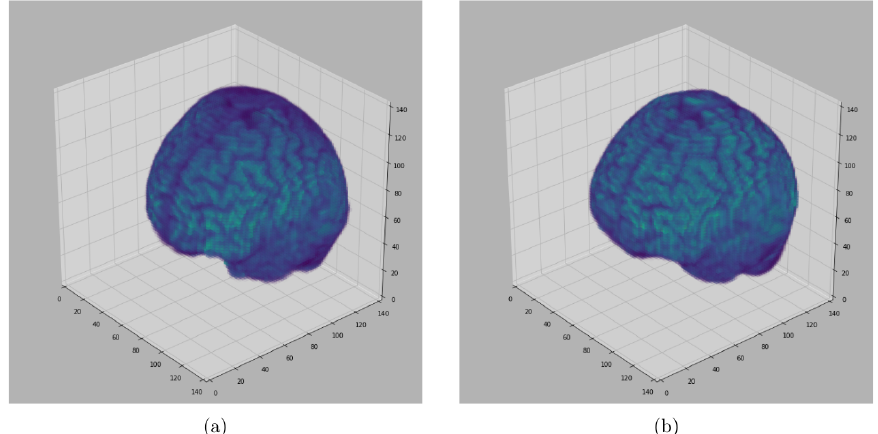
Figure 6. Segmented Brain (OASIS data): One representative subject representing ( a ) 3D brain segmented using GUBS approach (predicted), ( b ) 3D brain (ground truth). The masks were segmented using a custom method based on registration to an atlas, and then revised by human experts.